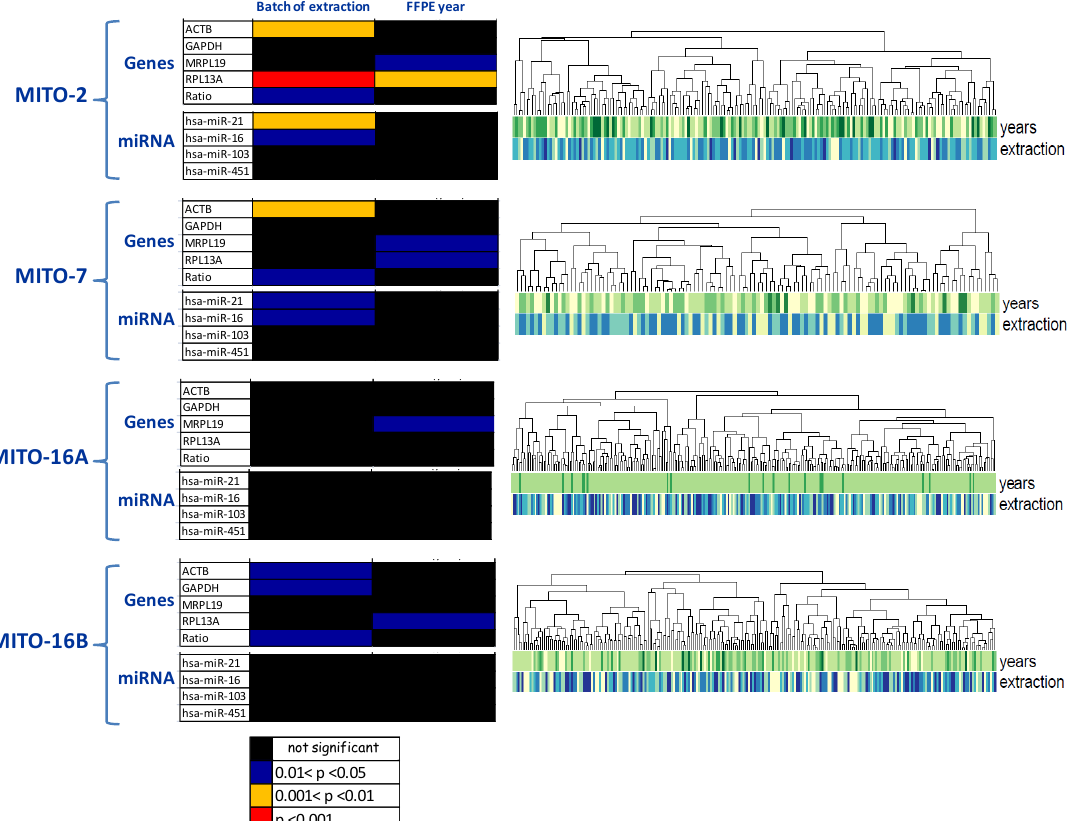
Figure 4. Pre-analytical systematic effects influencing the quality of RNA extracted from FFPE blocks of the four selected MITO trials. Left : Kruskal–Wallis test to assess the effect of batch RNA extraction and the FFPE blocks’ age (years of blocks: 2003/2004/2005/2006/2007) on qRT-PCR expression of miRNAs, and genes selected for quality check purposes as they are highly expressed in tumors. Color codes indicate level of statistical significance. Right : Unsupervised hierarchical clustering of samples following gene expression analysis. Below the dendrogram, RNA quality parameters (i.e., year of sample inclusion and batch of RNA extraction) are depicted by colored bars.